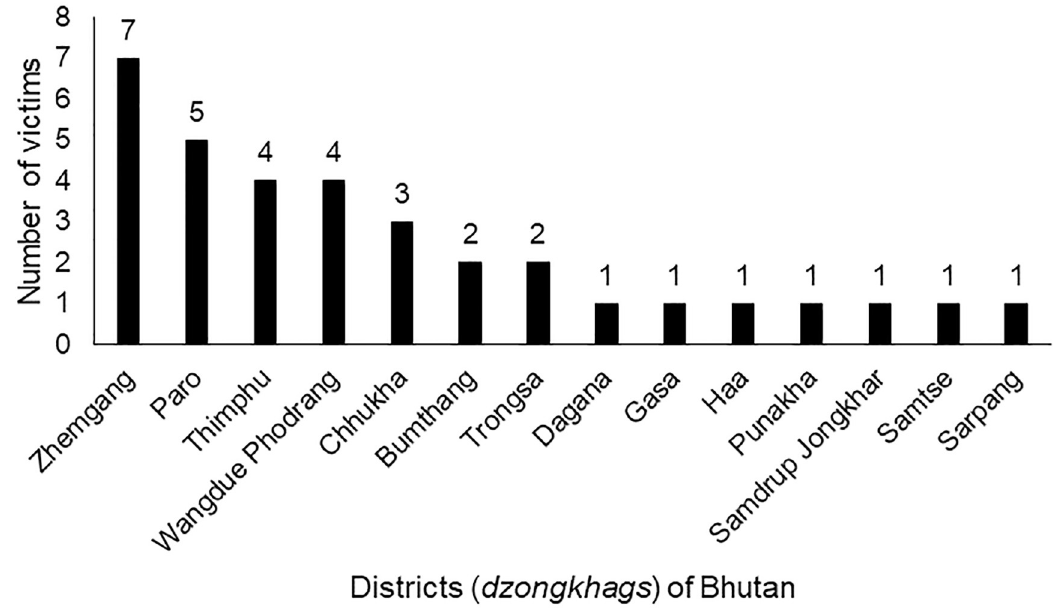
Fig 2. The distribution of victims of bear attacks by districts who received care at the Jigme Dorji Wangchuck National Referral Hospital, Bhutan during the period 2015–2019.